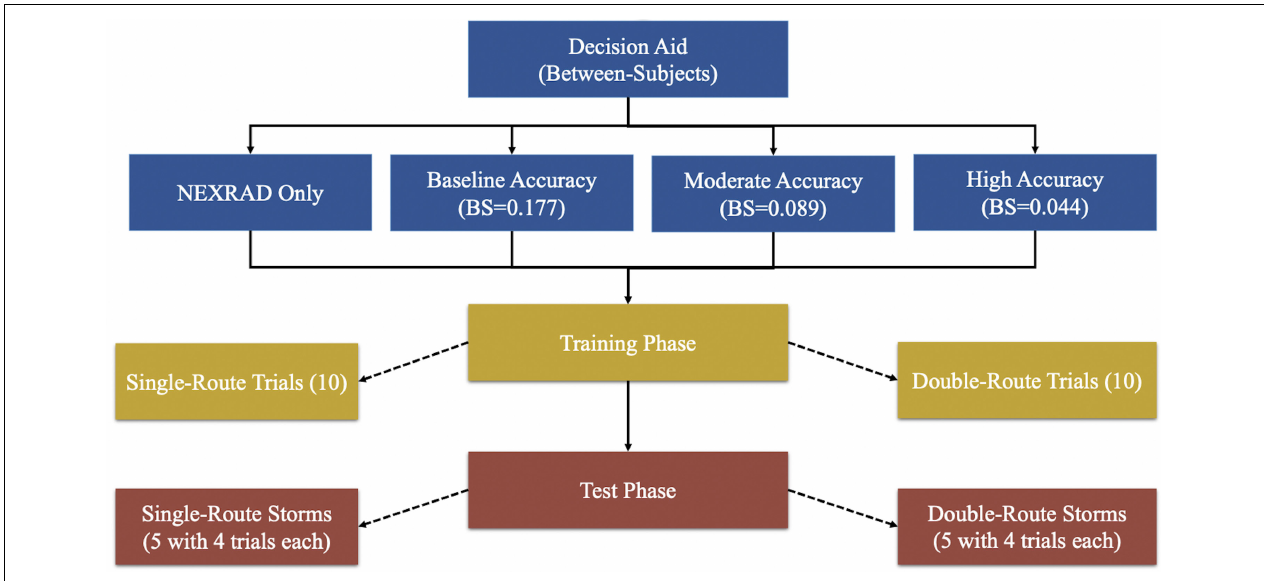
FIGURE 1 | Overview of experimental